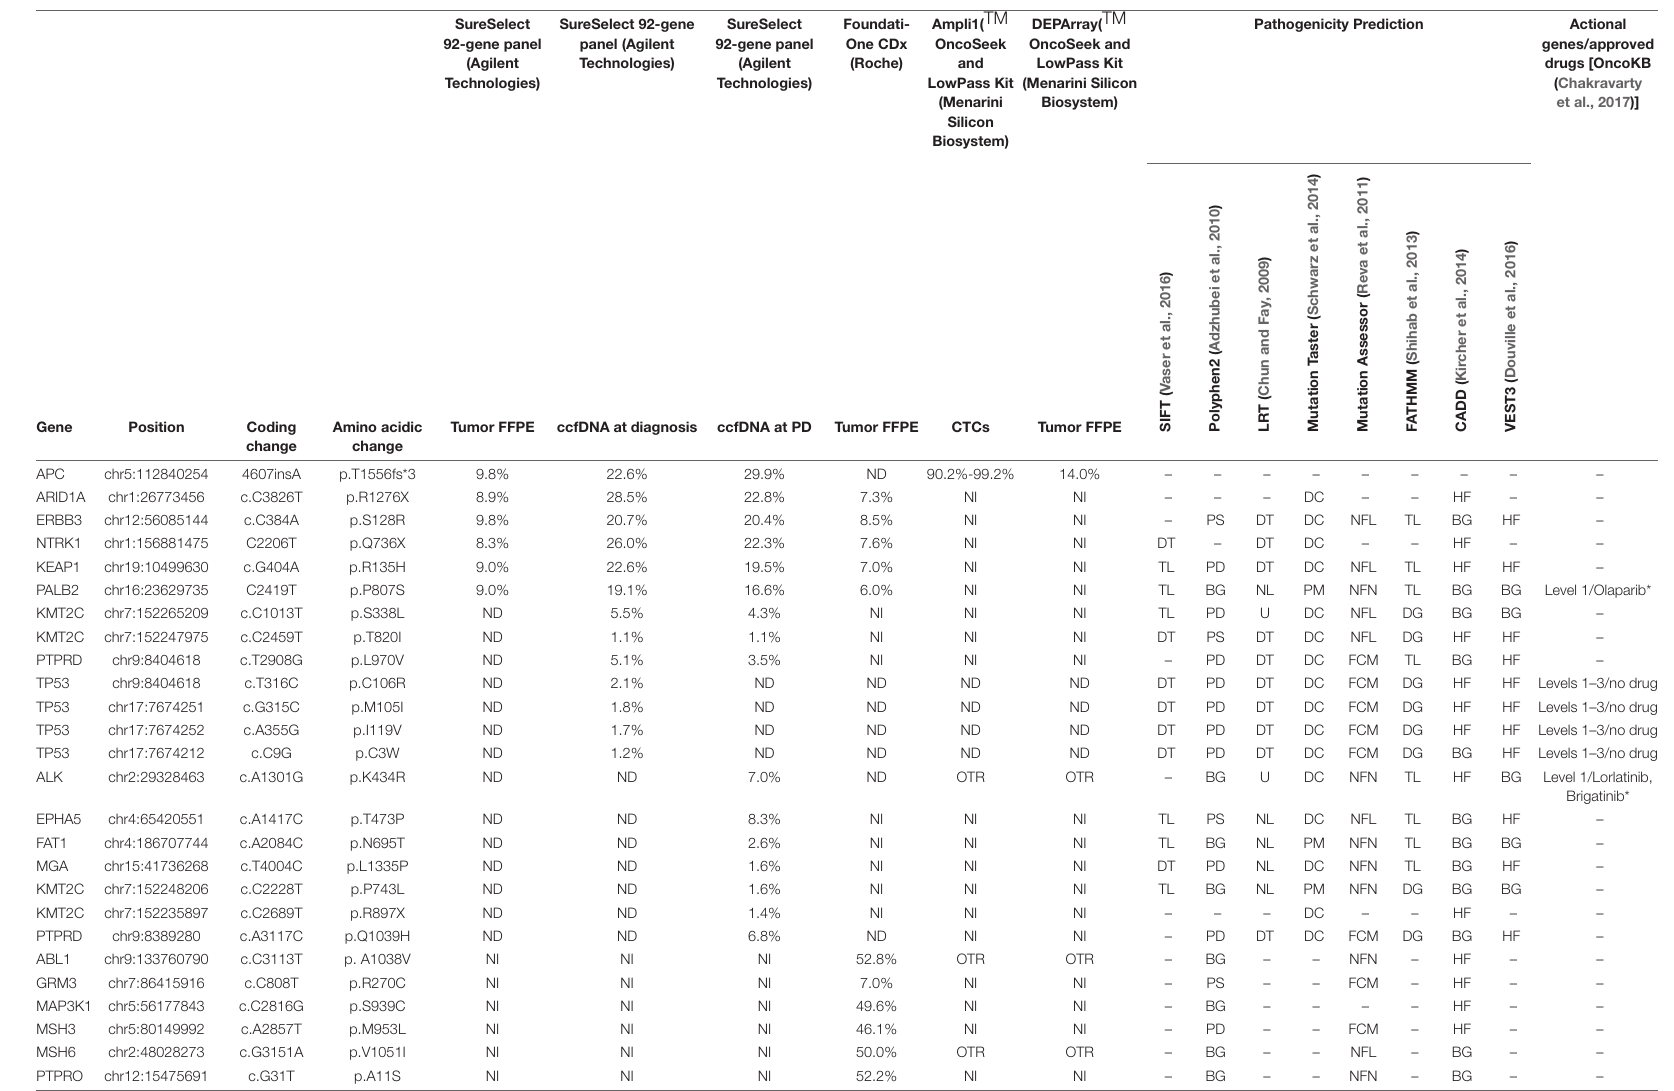
TABLE 1 | Mutation report of tumor, ccfDNA, and CTCs from